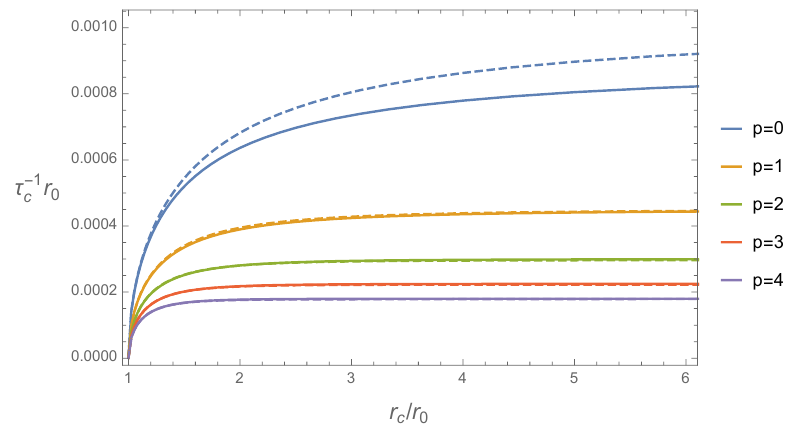
Figure 1 . The momentum relaxation rate (cid:28) (cid:0) 1